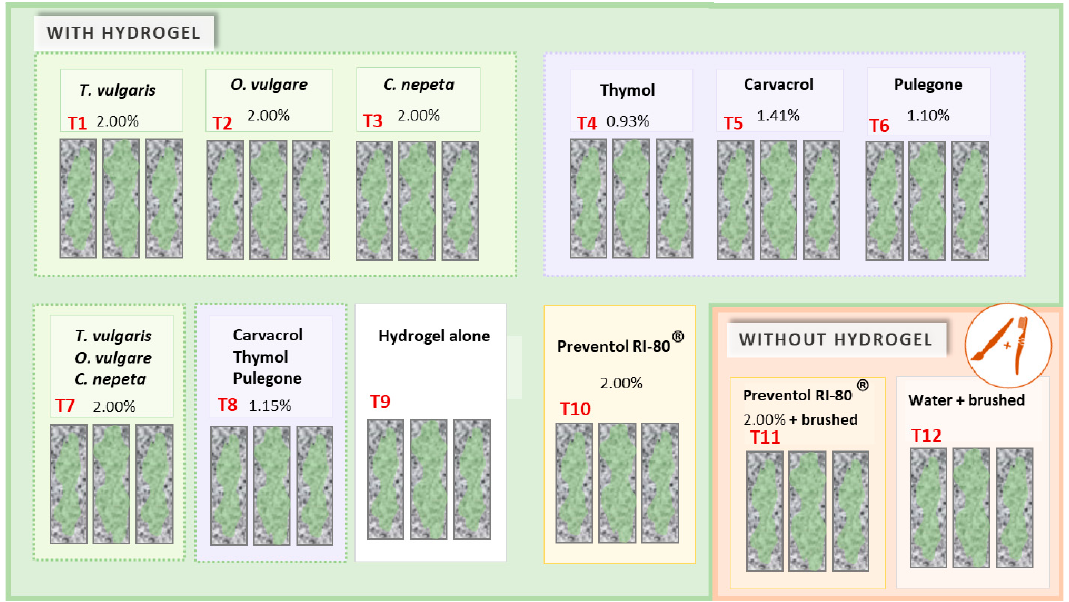
Figure 2. Schematic diagram of the experimental setup for testing the phytochemical compounds as cleaning agents.